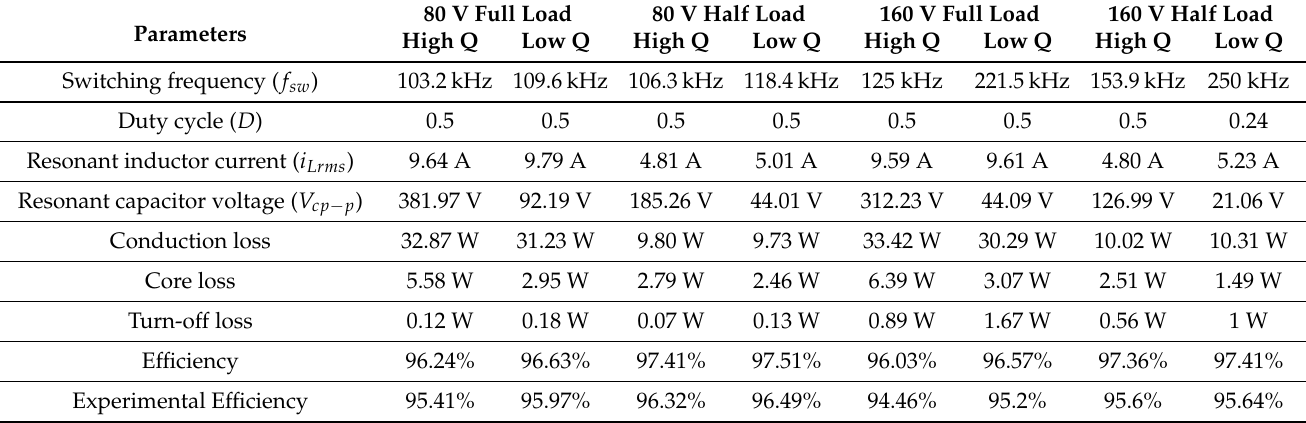
Table 5. Comparison of a high Q converter with conventional modulation and a low Q converter with the proposed